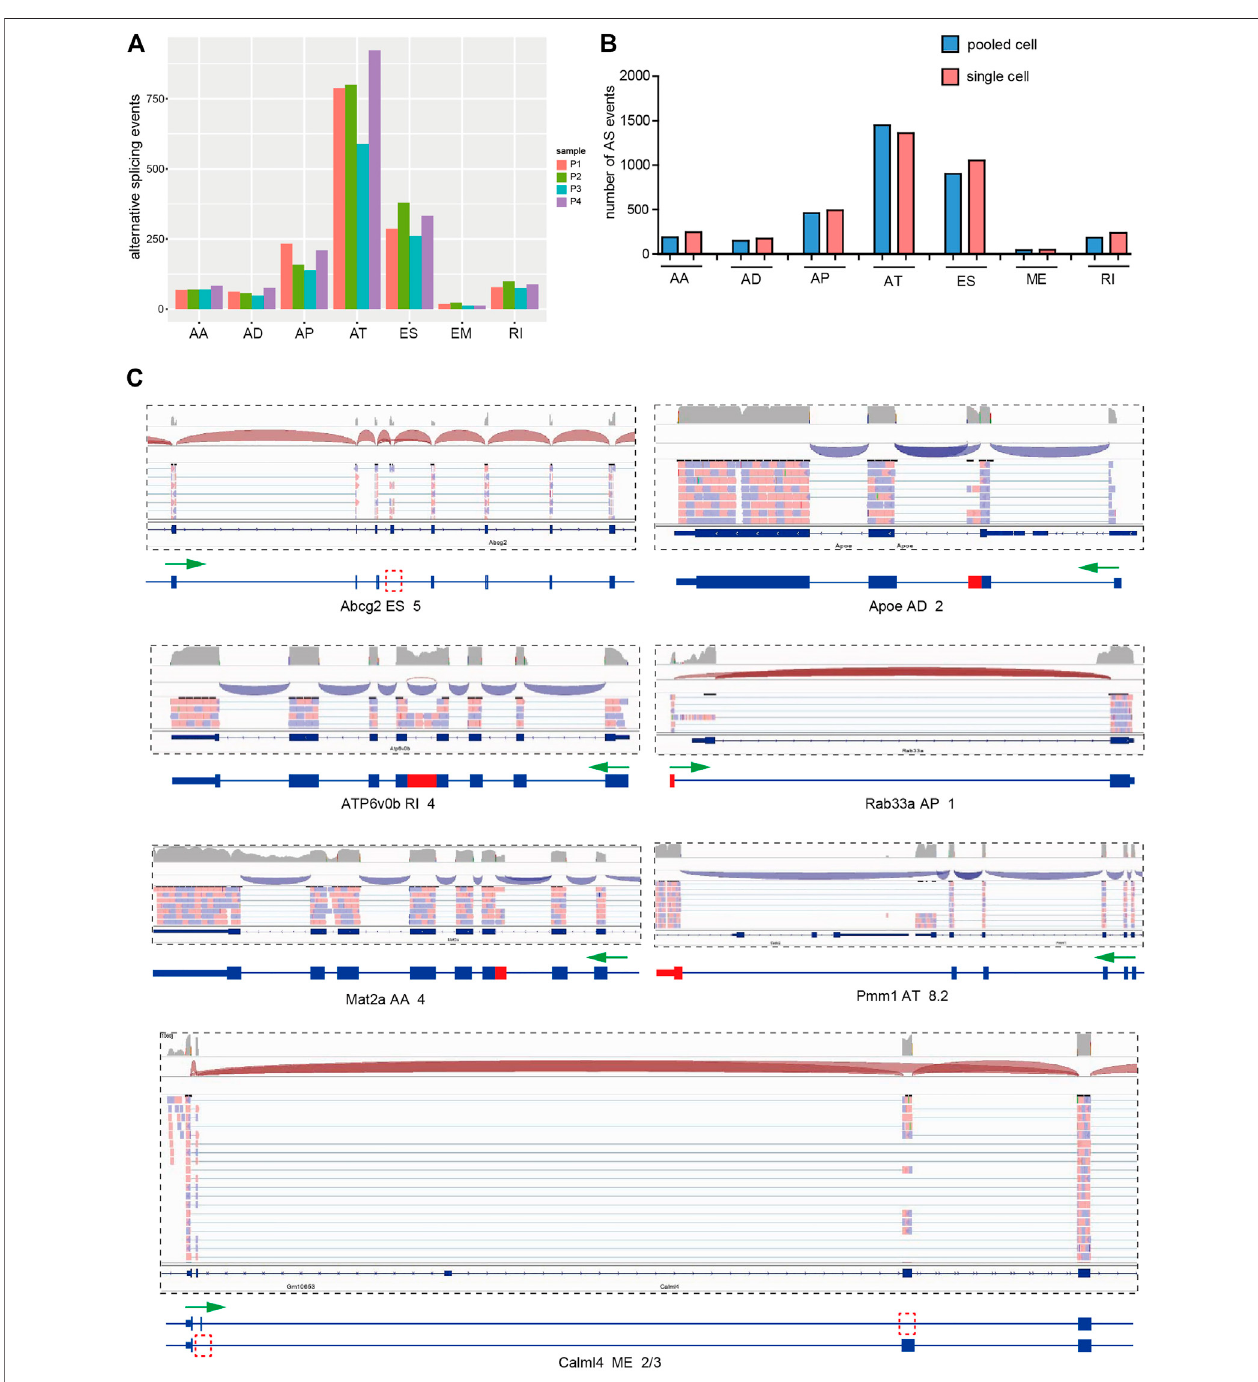
FIGURE 2 | Discovery of low-abundance AS events by single-cell RNA-Seq. (A) Number and type of AS events of four pooled-cell samples. The pooled-cell samples were collected and mixed ten CD133-positive and ten CD133-negative single-cell libraries, respectively, and two mixed/pooled ten CD133-positive samples and twomixed/pooled ten CD133-negative sampleswere sequenced. (B) Comparison ofnumber and type ofAS events between 28 single-cell samplesand 4pooled- cell samples. (C) Example of low-abundance and novel AS events existing only in single-cell samples showed by IGV visualization. Arrows in green mark the direction of transcription, and the location of alternative splicing is indicated in red.